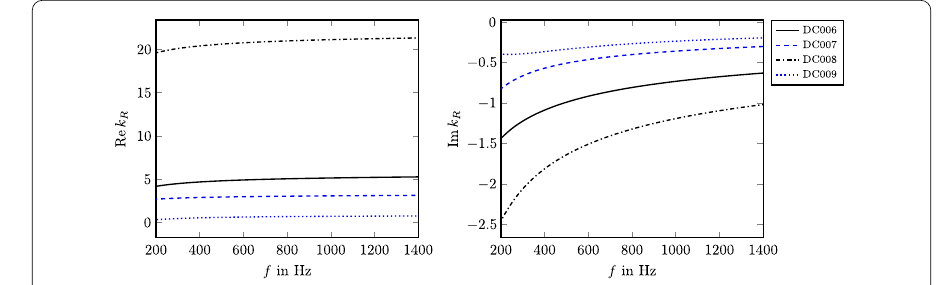
Figure 6 Real and imaginary parts of k R in dependence of the frequency f = ω